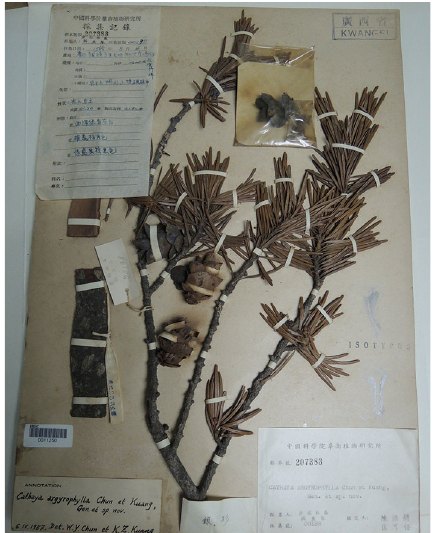
Figure 2. Specimen of Cathaya argyrophylla published by Prof. Huan-Yong Chen and Prof. Kuang